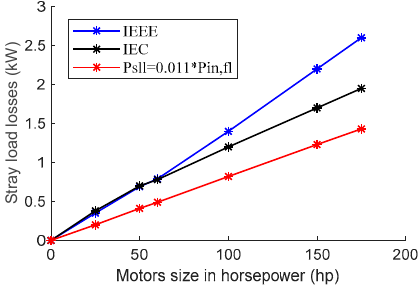
Figure 1. Comparison of three methods of stray load loss determination.